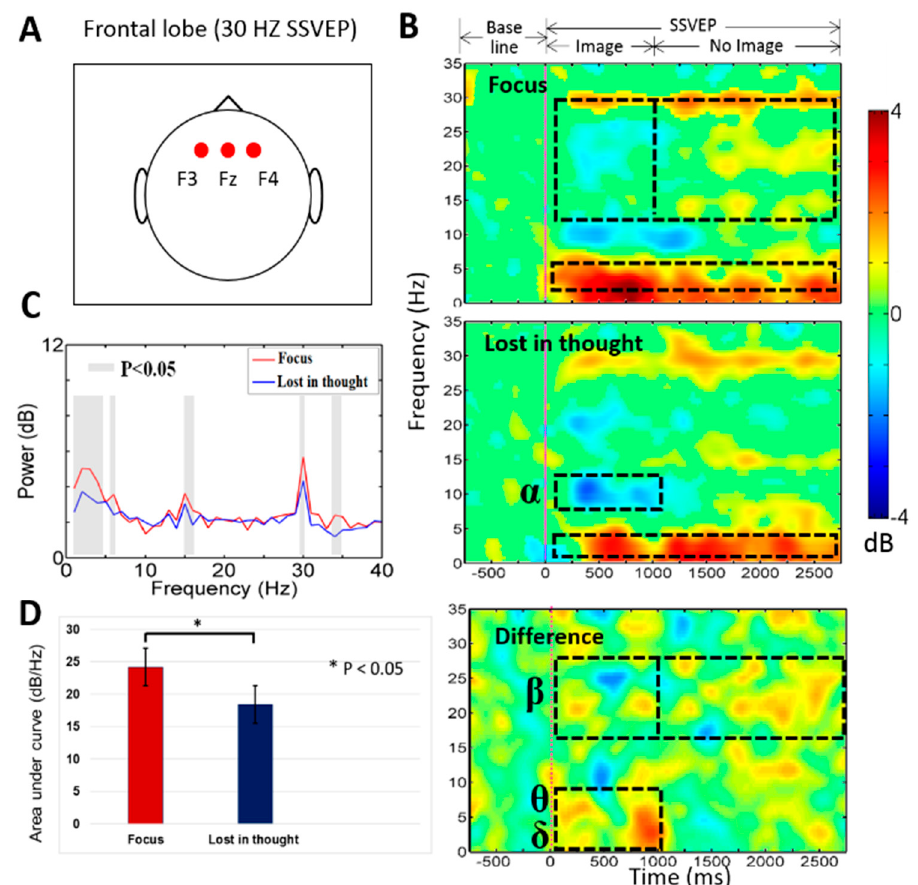
Figure 5. ( A ) Presents F3, Fz, F4 electrodes location in frontal lobe. ( B ) The ERSP was observed during focus and lost-in-thought states at 30 Hz SSVEP. The pink vertical line display the stimulus onset. Statistic at p < 0.05. Color bar indicate the scale of significant ERSP in decibel (dB). ( C ) The PSD for the mental focus state (red line) and lost-in-thought state (blue line). The grey areas represents the statistically pairwise significant difference (p < 0.05) in t-tests between focus and lost-in-thought states. ( D ) The AUC was investigated in mental focus and lost-in-thought states (*p < 0.05).